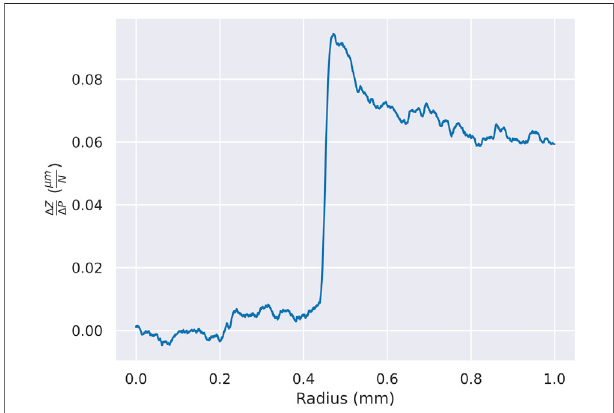
FIGURE 12 | The linear model of the effect on the indentation pro fi le of smallvariationsinthemaximumindentationload.Avariationof11 Ntranslates to roughly a one-micron difference in the pro fi le